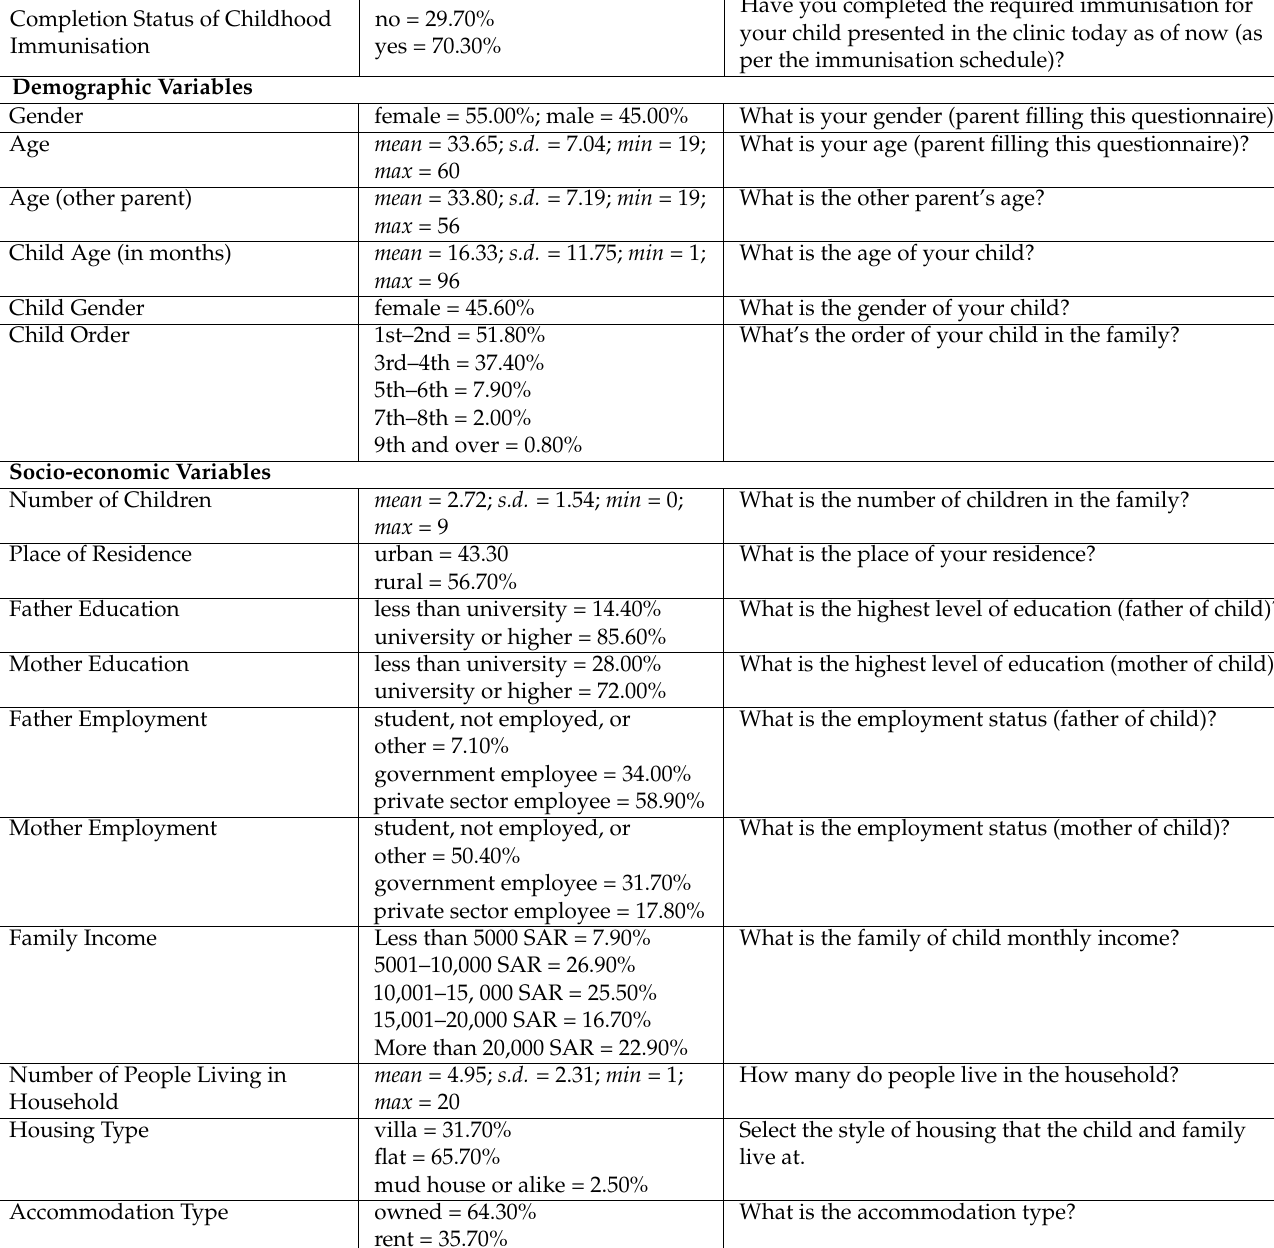
Table 2. Descriptive statistics of all